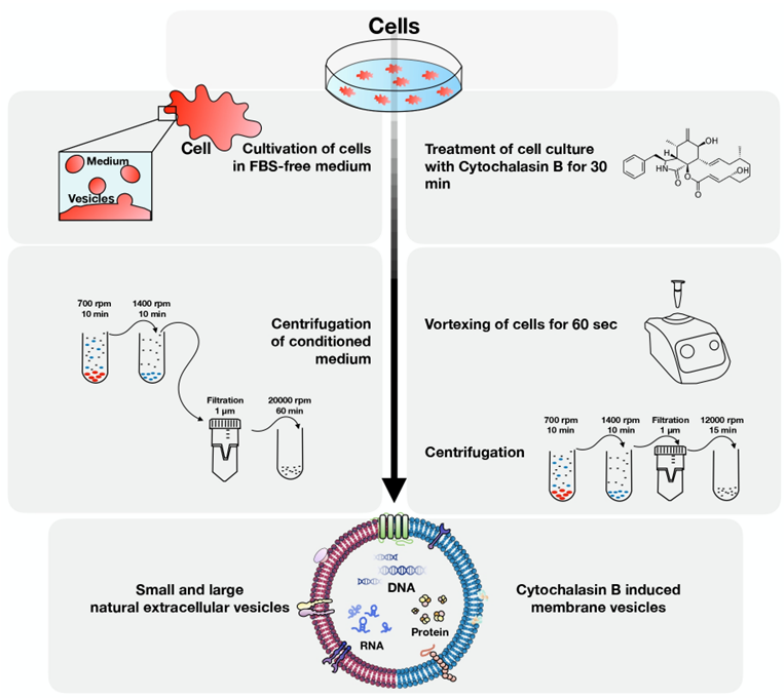
Figure 1. Production of cytochalasin B-induced membrane vesicles and natural extracellular vesicles. Isolation procedure design of CIMVs and NEVs.